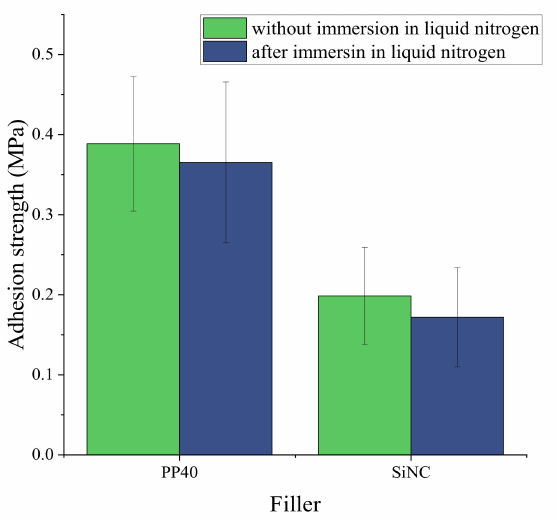
Figure 16. The adhesion strength of neat PP40 and PP40 composite with 1.25% silanized nanocellulose (SiNC)